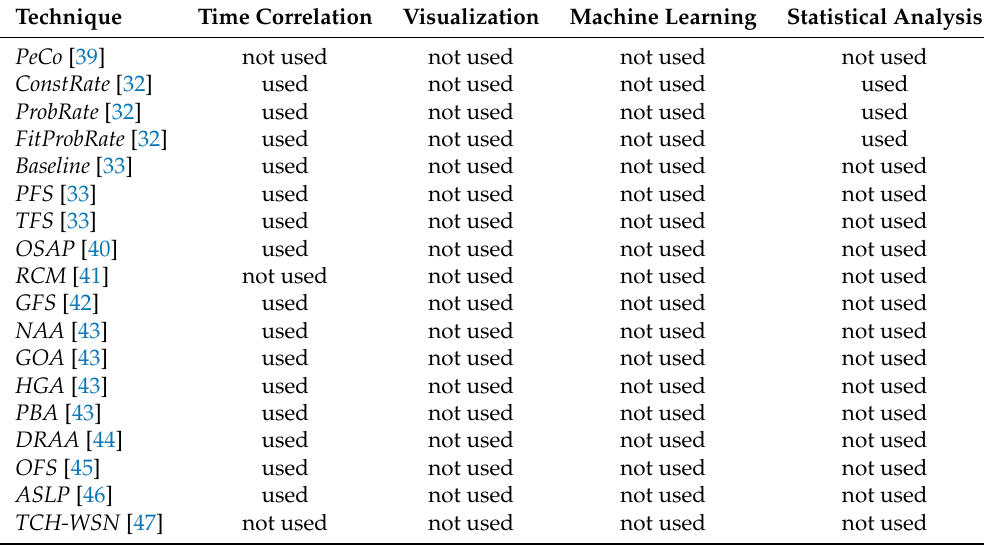
Table 3. Comparison of global adversary